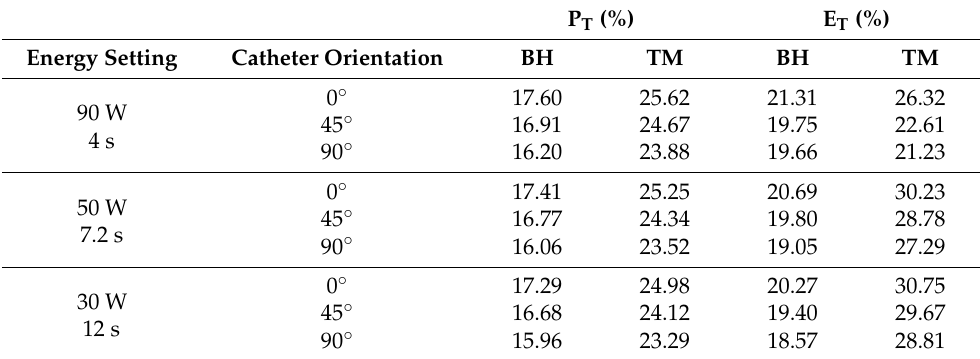
Power percentages are computed at 0 s (i.e., at the beginning of the RF pulse). Energy percentages are computed at the end of each RF pulse.